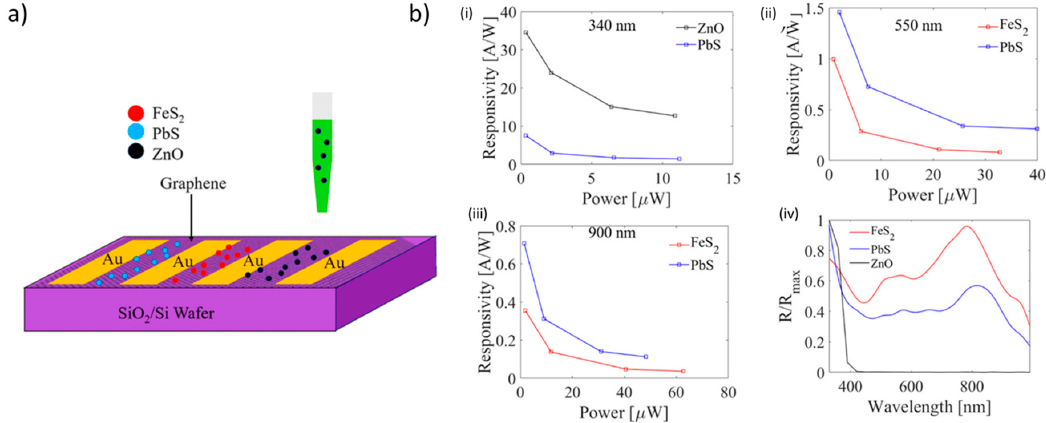
Figure 13. Inkjet-printed ZnO-based photodetectors. ( a ) Schematic representation of printing of ZnO quantum dots (QDs), PbS QDs, and FeS 2 NCs on graphene channels confined by Au electrodes on SiO 2 (500 nm) / Si substrates. ( b ) Photoresponsivity as a function of power is depicted in (i), (ii), and (iii) along with the normalized spectral curve shown in (iv). As evident, the best performances were obtained by the ZnO-based QDs. Reprinted from ref. [116] Copyright 2019 American Chemical Society.